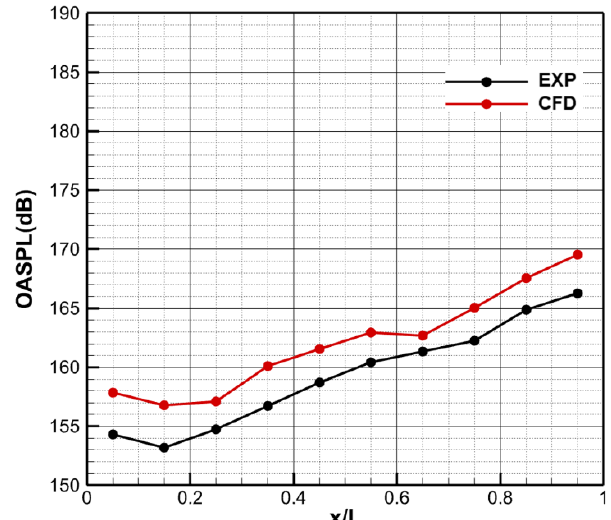
Figure 11. Overall sound-pressure level (OASPL) [43].